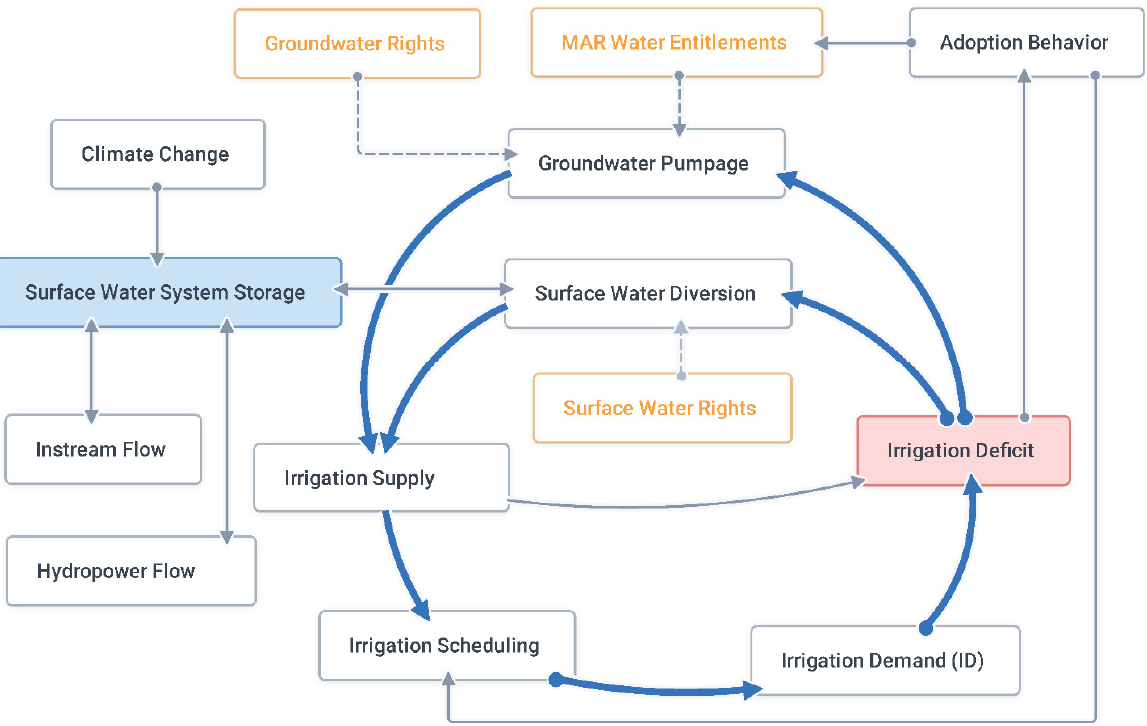
Figure 3. The conceptual map for the YRB system with focus on feedback between supply and demand. The solid arrows show connections between variables. The dashed arrows specify water right impacts. Directions of arrows indicate the impacts from one to the other. The blue highlighted arrows show the major feedback loops.